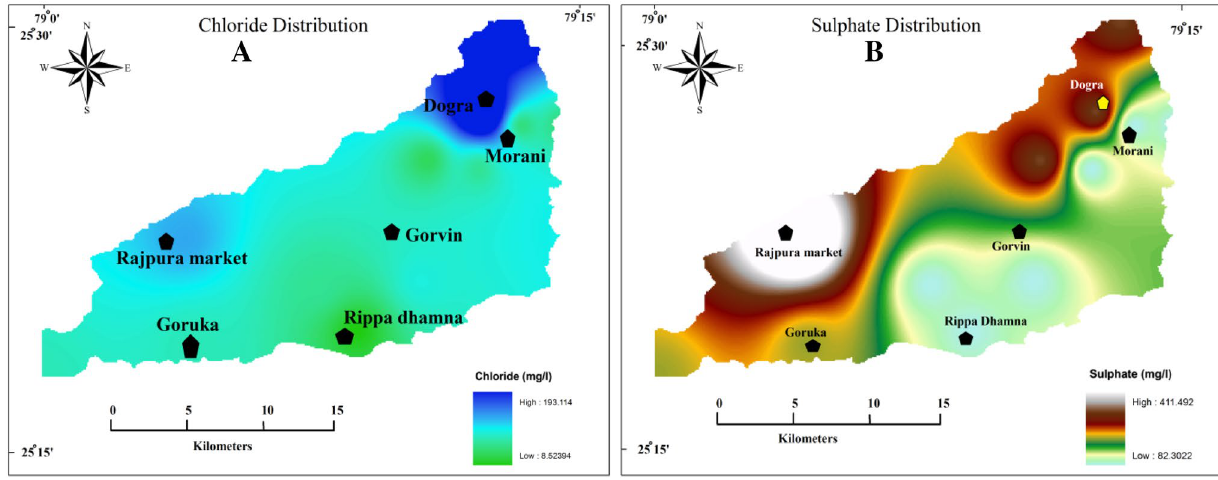
Fig. 5 Spatial distribution map of chloride and